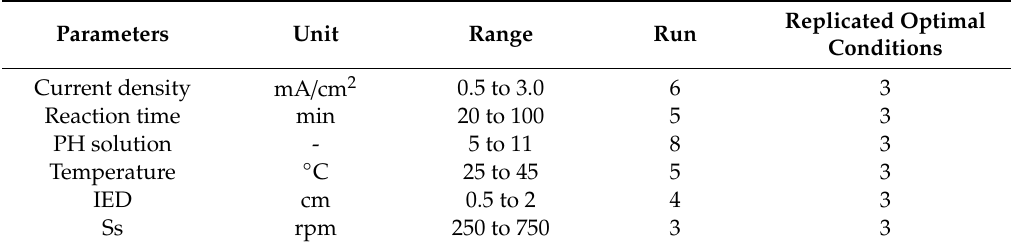
Table 1. Parameters included for removing total dissolved solids (TDS), chloride salt (Cl − ), bromine (Br − ) and sulphate (SO 42 − ) from lake water.